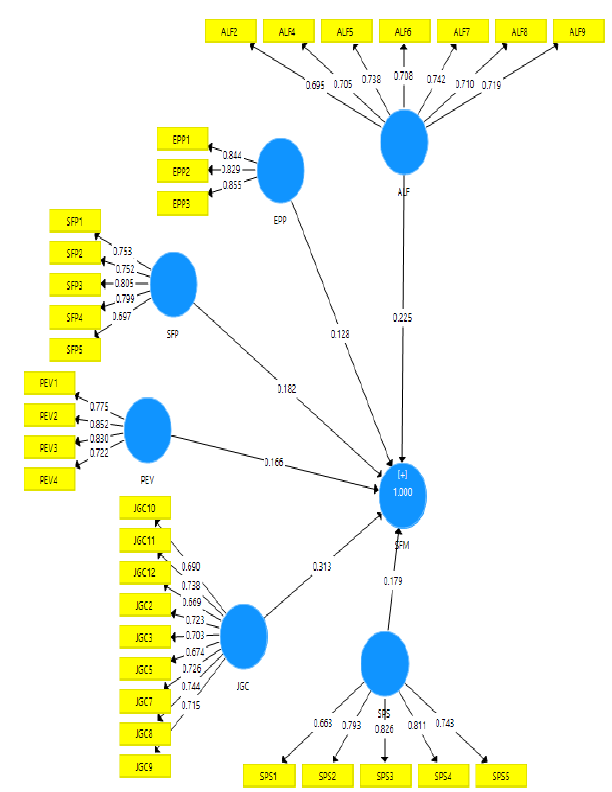
Figure 1.1 critical success factors structural model ( SFM